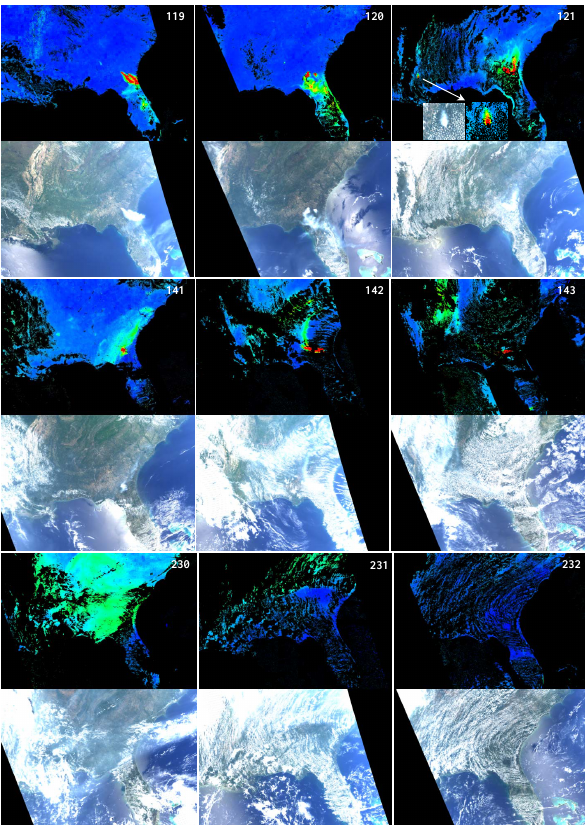
Fig. 4. Examples of MAIAC large-scale aerosol retrievals for the south-eastern US using MODIS Aqua 2007 data. The numbers show the day of the year. The scale of AOT 0 . 47 is 0–3. The top two rows of images show triplets of consecutive days for the Georgia- Florida fires of 2007. An additional large fire on day 121 in Alabama is magnified in the inset. Days 141–143 illustrate conditions of in- creasing cloudiness with reliable identification of the fire source and north-western transport of smoke. The last three days (230–232) show a gradual removal of polluted air by the weather system in the northern